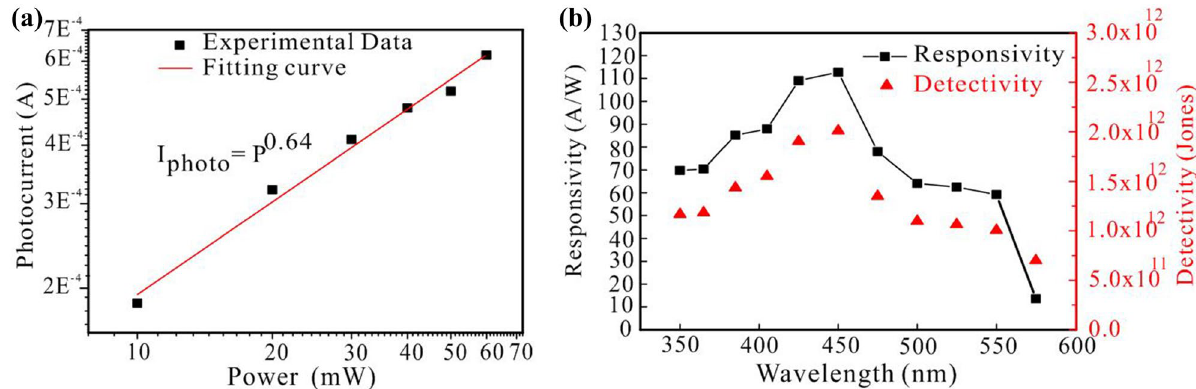
Figure 5. ( a ) The I-P curve measurement of the SSG device illuminated by the 405 nm laser at different laser powers. ( b ) Photo-responsivity of SSG at 15 V under 405 nm